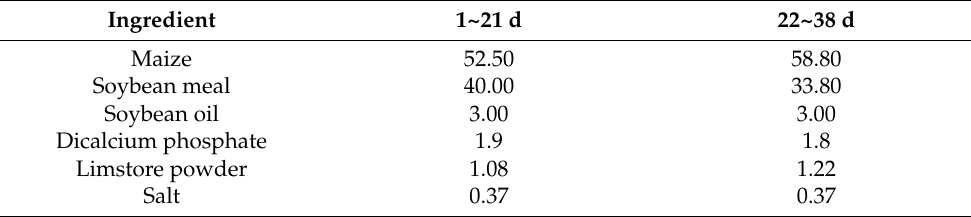
Table 1. Basal diet composition and its nutrient level (air-dried basal)